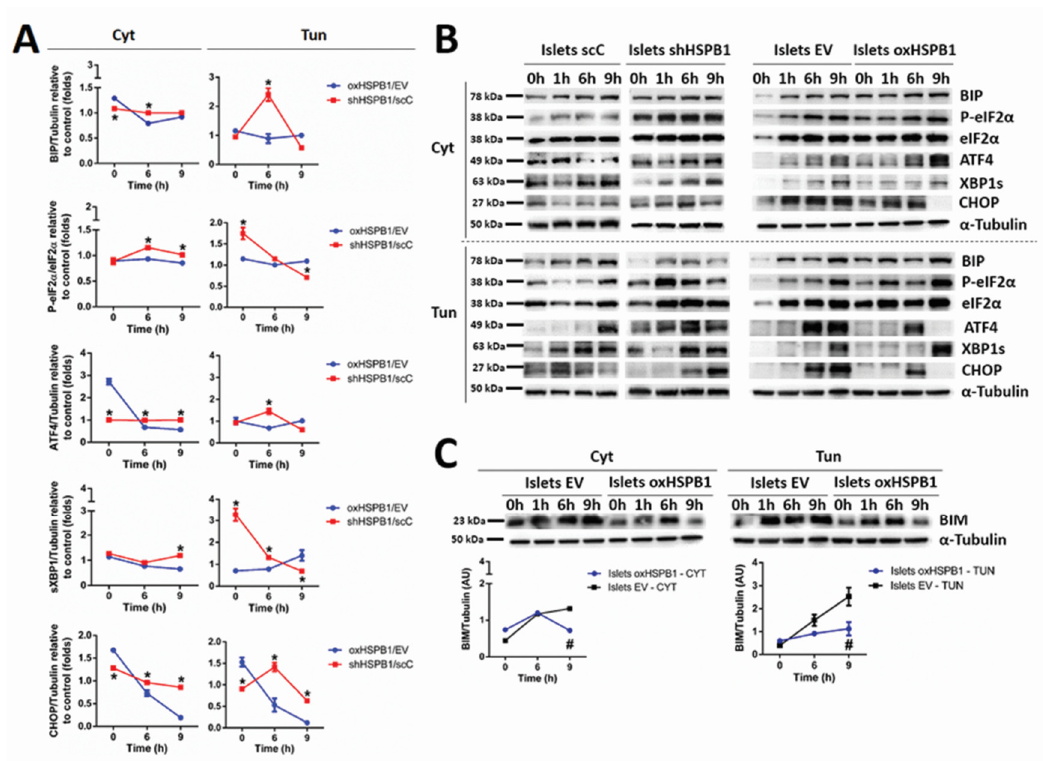
Figure 2. HSPB1 overexpression attenuates ER stress induced by proinflammatory cytokines or tunicamycin in mouse islets. HSPB1-silenced (shHSPB1) and HSPB1-overexpressing (oxHSPB1) mouse islets, as well as their respective controls (scC, EV), were exposed to a combination of cytokines (TNF- α 8 ng/mL, IFN- γ 16 ng/mL, IL-1- β 1.6 ng/mL) or tunicamycin (7.5 µg/mL) for 6 and 9 h. Protein expression of BIP, ATF4, XBP1s, and CHOP, as well as phosphorylation state of eIF2 α , was analyzed by Western blotting. ( A ) Graphical representation of BIP, eIF2 α , ATF4, XBP1s, and CHOP protein levels presented as arbitrary densitometry units (AU). After normalization to the corresponding α -tubulin content, the data of the silenced (Min6 shHSPB1, Islets shHSPB1) or overexpressed (Min6 oxHSPB1, Islets oxHSPB1) HSPB1 cells were plotted as the ratio between the values obtained in silenced or overexpressing cells and those in their respective controls (scC or EV). ( B ) Immunoblots of islets are shown as representative results. ( C ) Graphical representation of normalized protein levels and immunoblots of BIM protein levels in islets presented as arbitrary densitometric units (AU). Each data point represents the mean ± SEM from three replicates and at least three independent experiments carried out for each cell type submitted to the different cell incubation conditions; * p < 0.05 vs. oxHSPB1/EV; # p < 0.05 vs. EV.